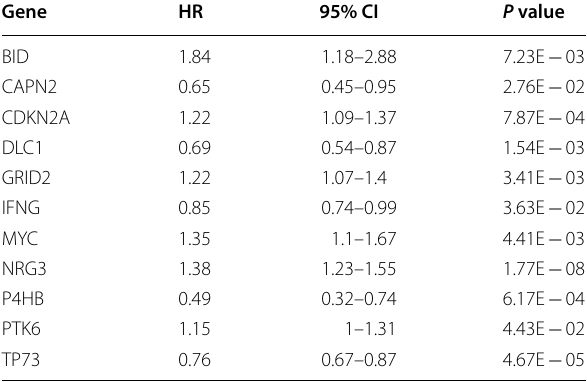
Table 1 Univariate Cox regression analysis of the 11